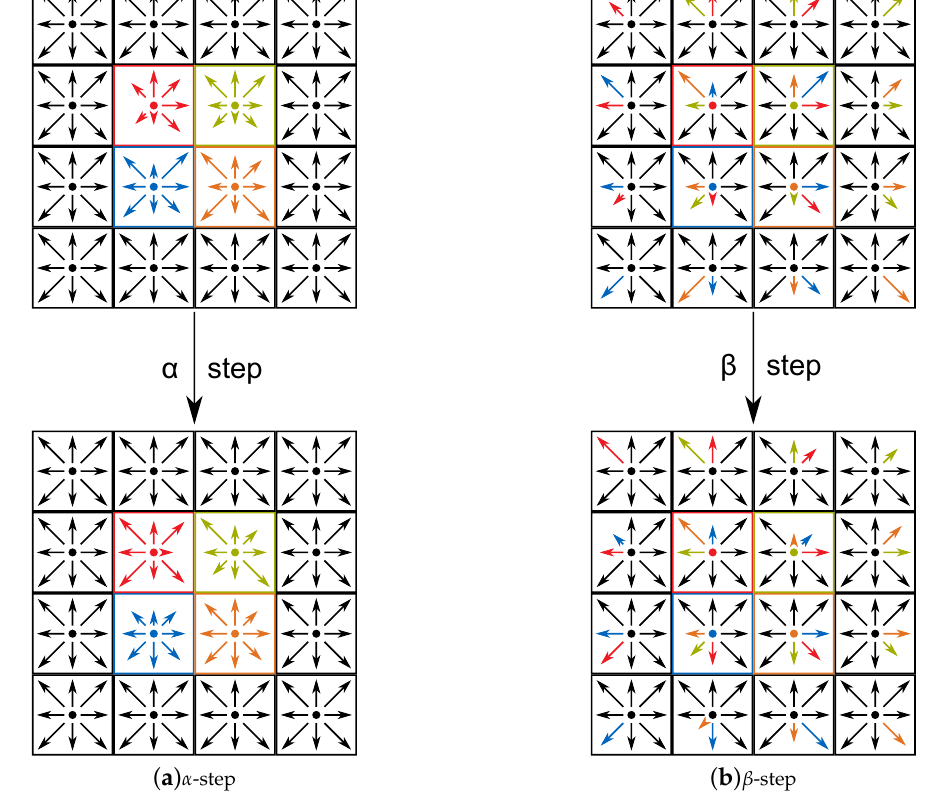
Figure 3. Probability densities of four processed cells (colored in red, green, blue, and orange) affected by memory accesses using the A-A memory layout pattern [19]. Different lengths of same-color arrows in the same direction represent an update of the probability densities due to a collision step. ( a ) Illustrates the α -step consisting of one collision step, ( b ) depicts the β -step consisting of two propagation steps and one collision